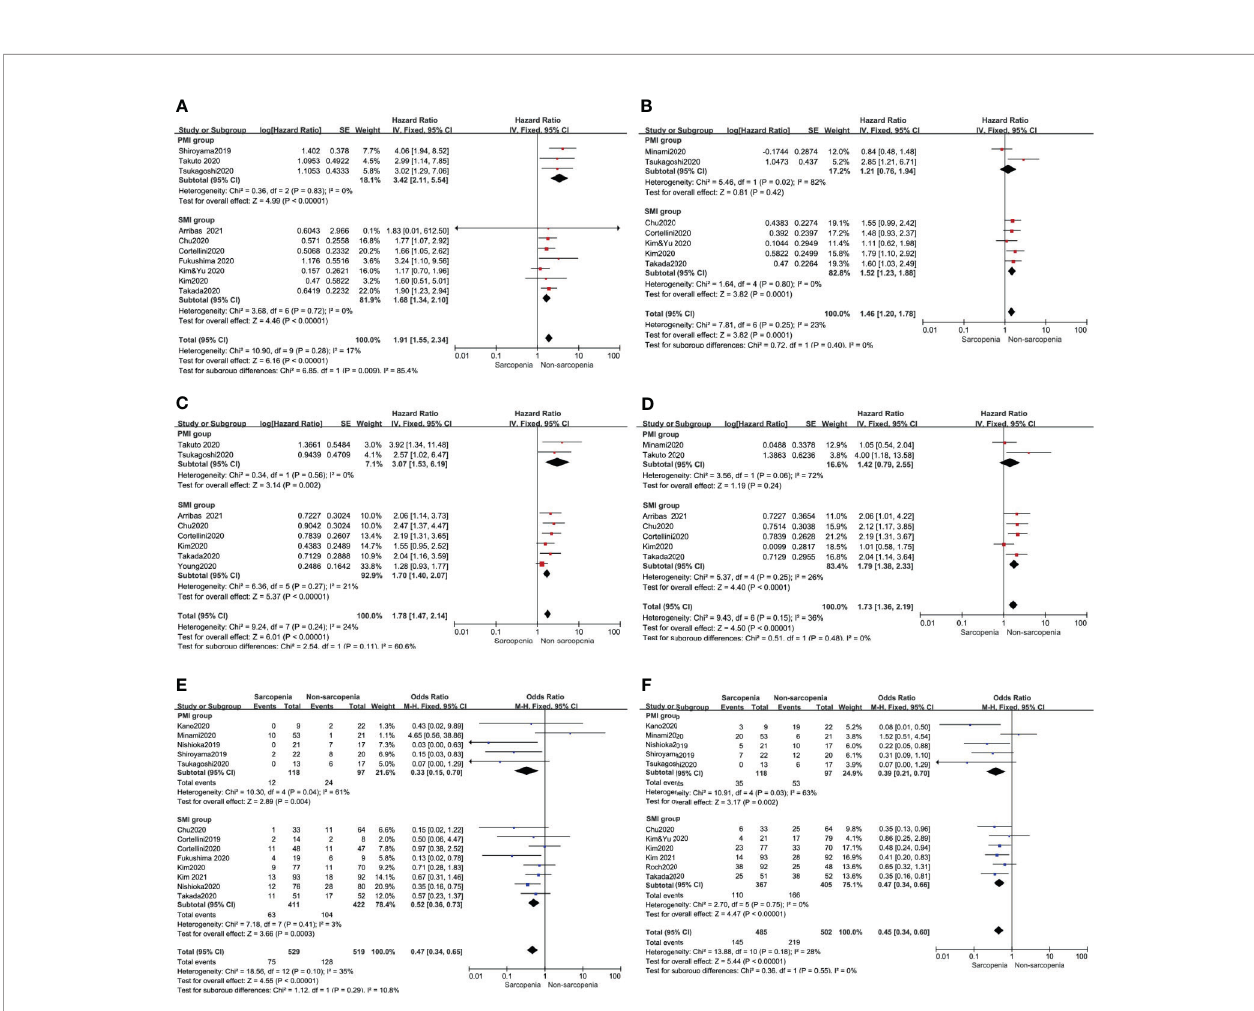
FIGURE 3 | Subgroup analysis including SMI and PMI group. (A) Sarcopenia and PFS(by univariate HR), (B) Sarcopenia and PFS(by multivariate HR), (C) Sarcopenia and OS(by univariate HR), (D) Sarcopenia and OS(by multivariate HR) (E) Sarcopenia and ORR, (F) Sarcopenia and